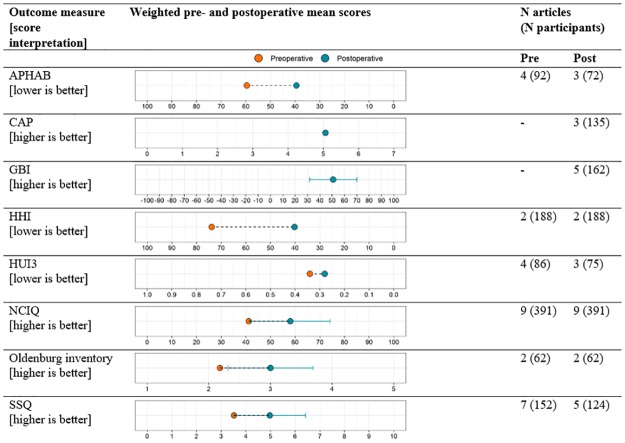
Pooled data from studies reporting on formal self-report outcome measures.APHAB, Abbreviated Profile of Hearing Aid Benefit; CAP, Categories of Auditory Performance; GBI, Glasgow Benefit Inventory; HUI3, Health Utilities Index 3; HHI, Hearing Handicap Inventory; NCIQ, Nijmegen Cochlear Implant Questionnaire; SSQ, Speech, Spatial and Qualities of Hearing Scale. Error bars show weighted standard deviation.